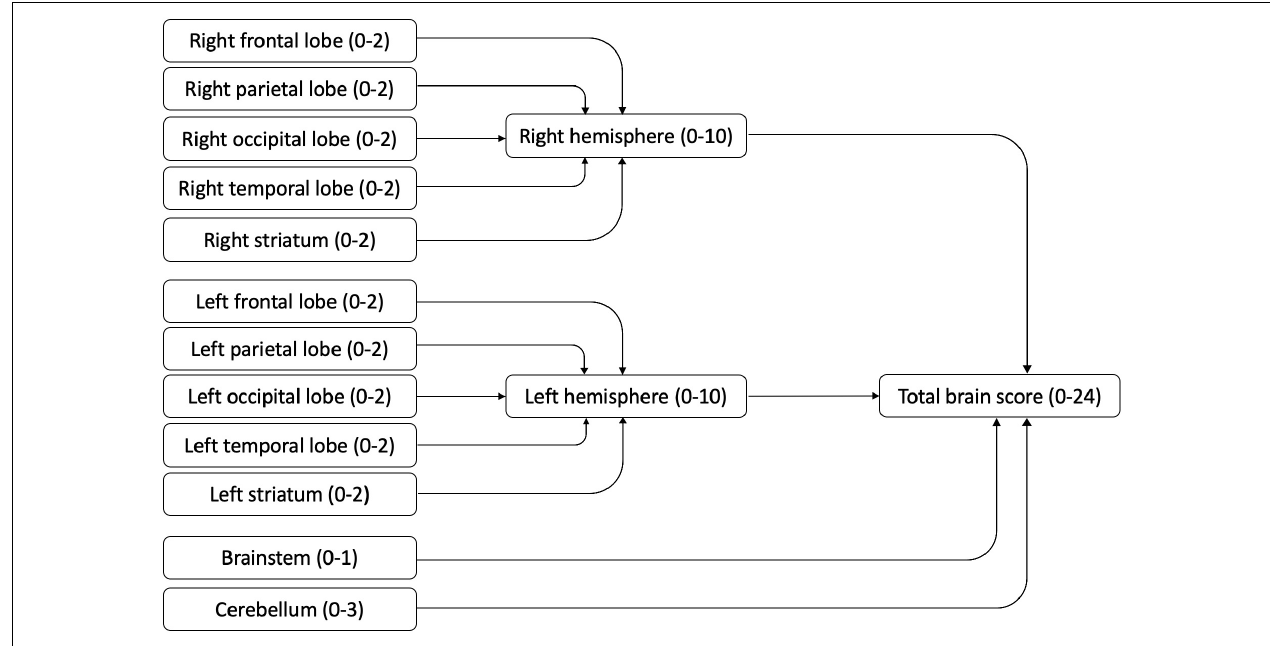
FIGURE 1 | MRI scoring template (based on Fiori et al.,